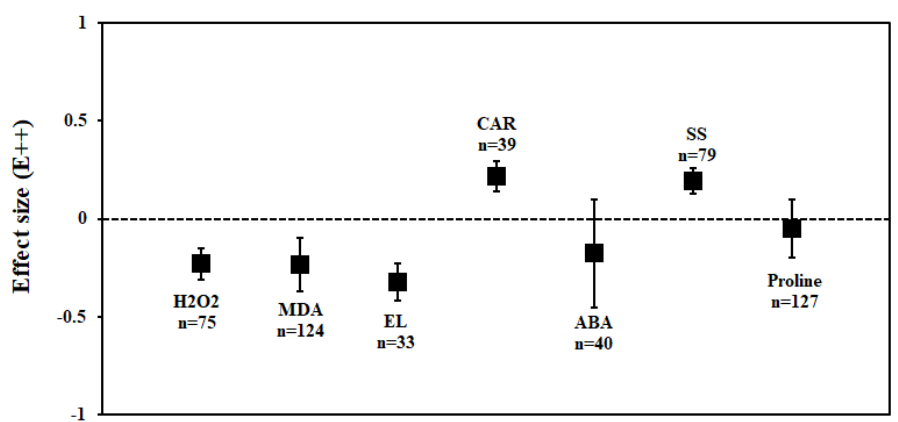
Figure 2. Effect of arbuscular mycorrhizal inoculation responses on non-enzymatic antioxidants under drought stress. Error bars are means ± 95% confidence intervals (CIs). Where the CIs do not overlap the horizontal dashed lines, the effect size for a response variable is significant at p < 0.05. The numbers of observations are shown above the bar. Note: H 2 O 2 − Hydrogen peroxide,